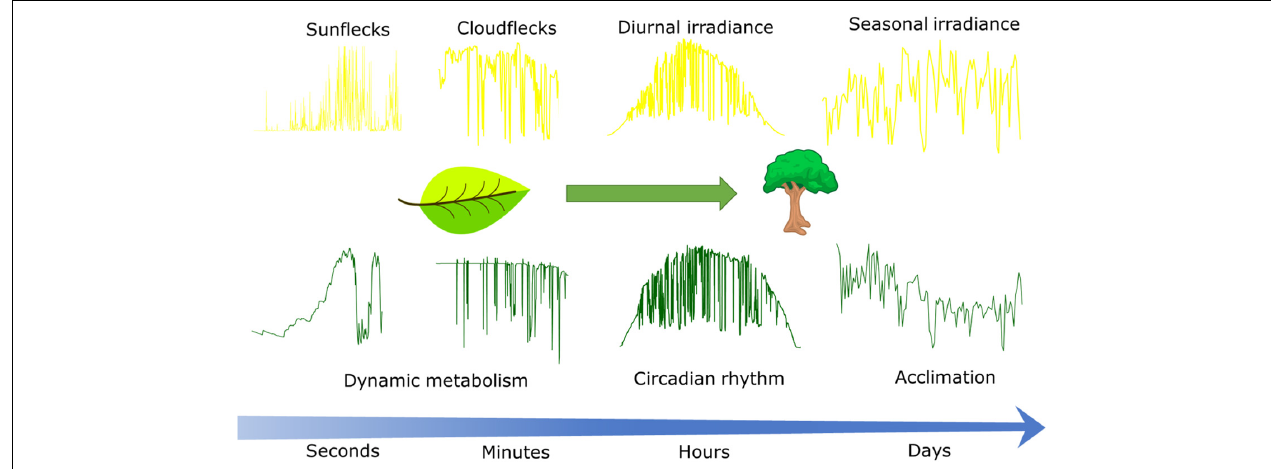
FIGURE 1 | Conceptual scheme describing the time scales at which irradiance fluctuates in the field (Upper) and responses of CO 2 assimilation to these fluctuations (Lower) . Leaf CO 2 assimilation in response to sunflecks and cloudflecks as driven by dynamic metabolism was simulated with the dynamic photosynthesis model by Morales et al. (2018a). Canopy CO 2 assimilation in response to diurnal and seasonal weather was simulated with the sun-shade canopy photosynthesis model by De Pury and Farquhar (1997) and happens at the timescales at which circadian rhythms (hours) and the effects of acclimation (days) are relevant. Time series of irradiance from weather station in Wageningen, Netherlands, except for the sunflecks time series that was measured by the authors with a portable light sensor placed beneath a durum wheat canopy during a clear summer day in